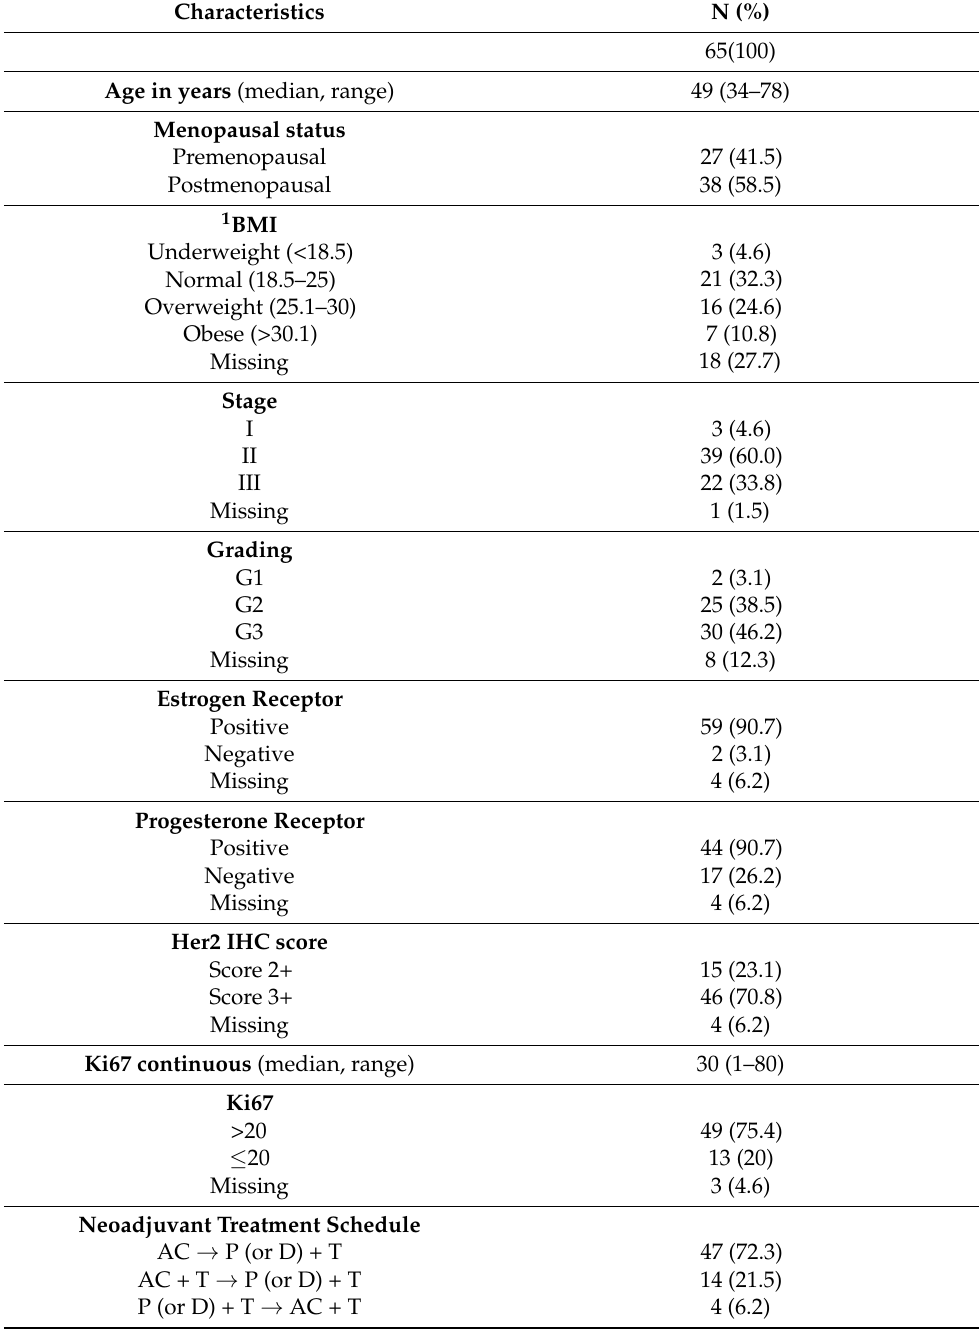
Table 1. Characteristics of the study participants (N =